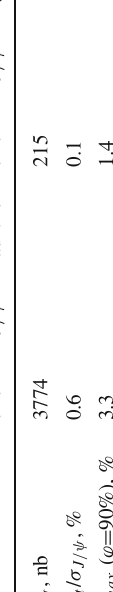
when taking into account the interference. The systematic uncertainties for the branching fractions of the J /ψ → X i decays under study, associated with possible interference with the continuum, shown in Table 2, were obtained under the assumption of correlated variations for the numbers of selected signal events of J /ψ → hadrons and J /ψ → X i decays.